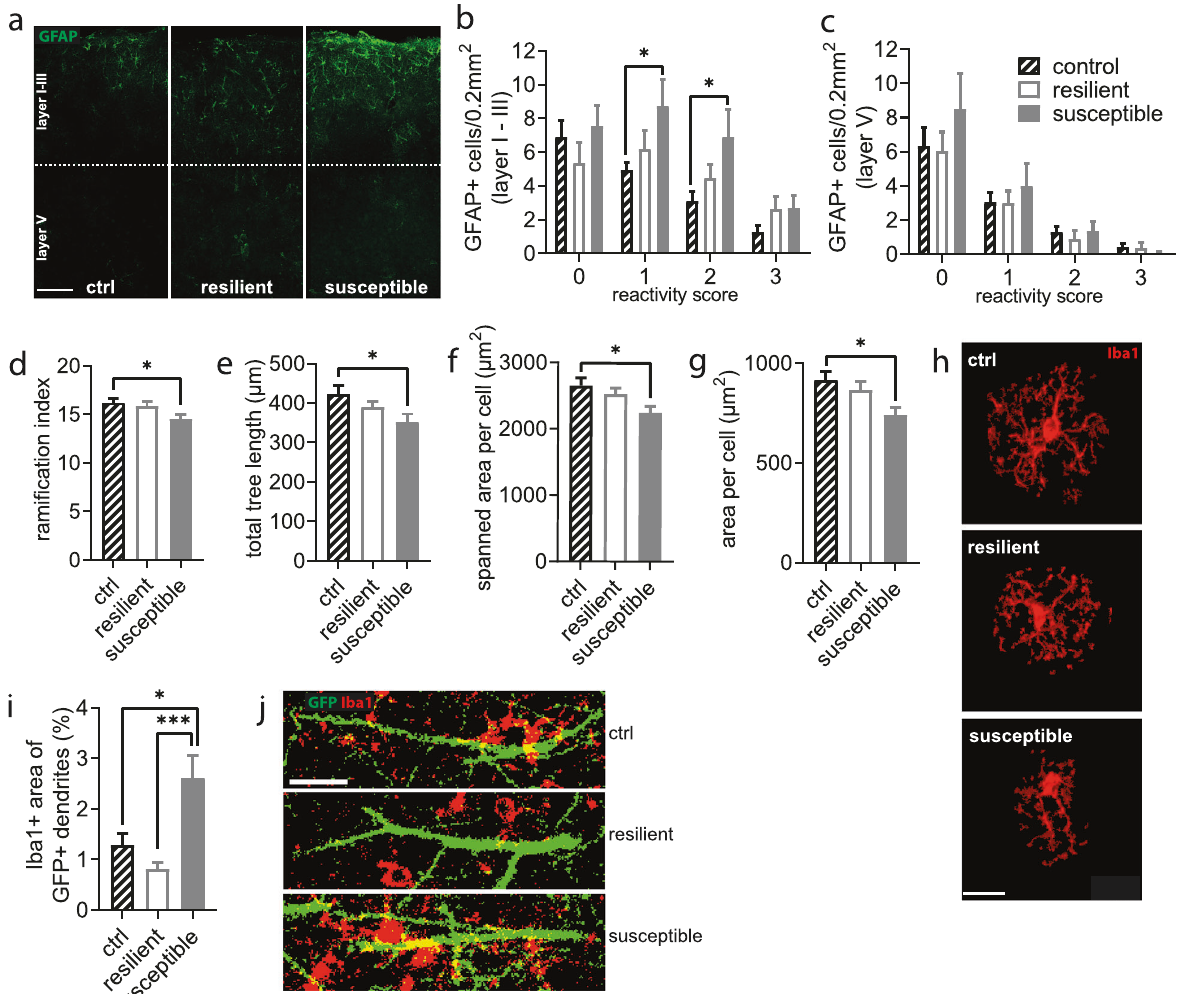
Fig. 4 Motor cortical glia cells show long-term response to CSDS. a – c Layer- and phenotype-speci fi c reactivity of astrocytes (Layer I – III: stress F 2,220 = 6.500, P = 0.002, reactivity score F 3,220 = 14.30, P < 0.0001, interaction F 6,220 = 1.140, P = 0.340, layer V: stress F 2,220 = 0.999, P = 0.370, reactivity score F 3,220 = 36.78, P < 0.0001, interaction F 6,220 = 0.509, P = 0.801, two-way ANOVA with Holm-Sidak ’ s post-hoc test when applicable). No. of ROIs/mice: ctrl n = 26/13, resilient n = 18/9, susceptible n = 14/7. d – h Morphological changes of Iba1 + microglia cells in layer I – III are limited to the susceptible group (rami fi cation index: F 2,121 = 3.148, P = 0.047, tree length F 2,121 = 3.576, P = 0.031, spanned area F 2,121 = 3.459, P = 0.035, total area F 2,121 = 4.061, P = 0.020, one-way ANOVA with Holm-Sidak ’ s post-hoc test). No. of cells/mice: ctrl n = 48/11, resilient n = 45/9, susceptible n = 31/6. i , j Microglia-dendrite colocalization was signi fi cantly increased in susceptible mice compared to controls but also markedly increased compared to resilient mice (H 2 = 14.69, P = 0.0006, Kruskal-Wallis test with Dunn ’ s post-hoc test). No. of dendrites/mice: ctrl n = 43/11, resilient n = 47/9, susceptible n = 36/6). Scale bar: 200 µm in a, 20 µm in h , j . * P < 0.05, *** P < 0.001. Results are shown as mean ±